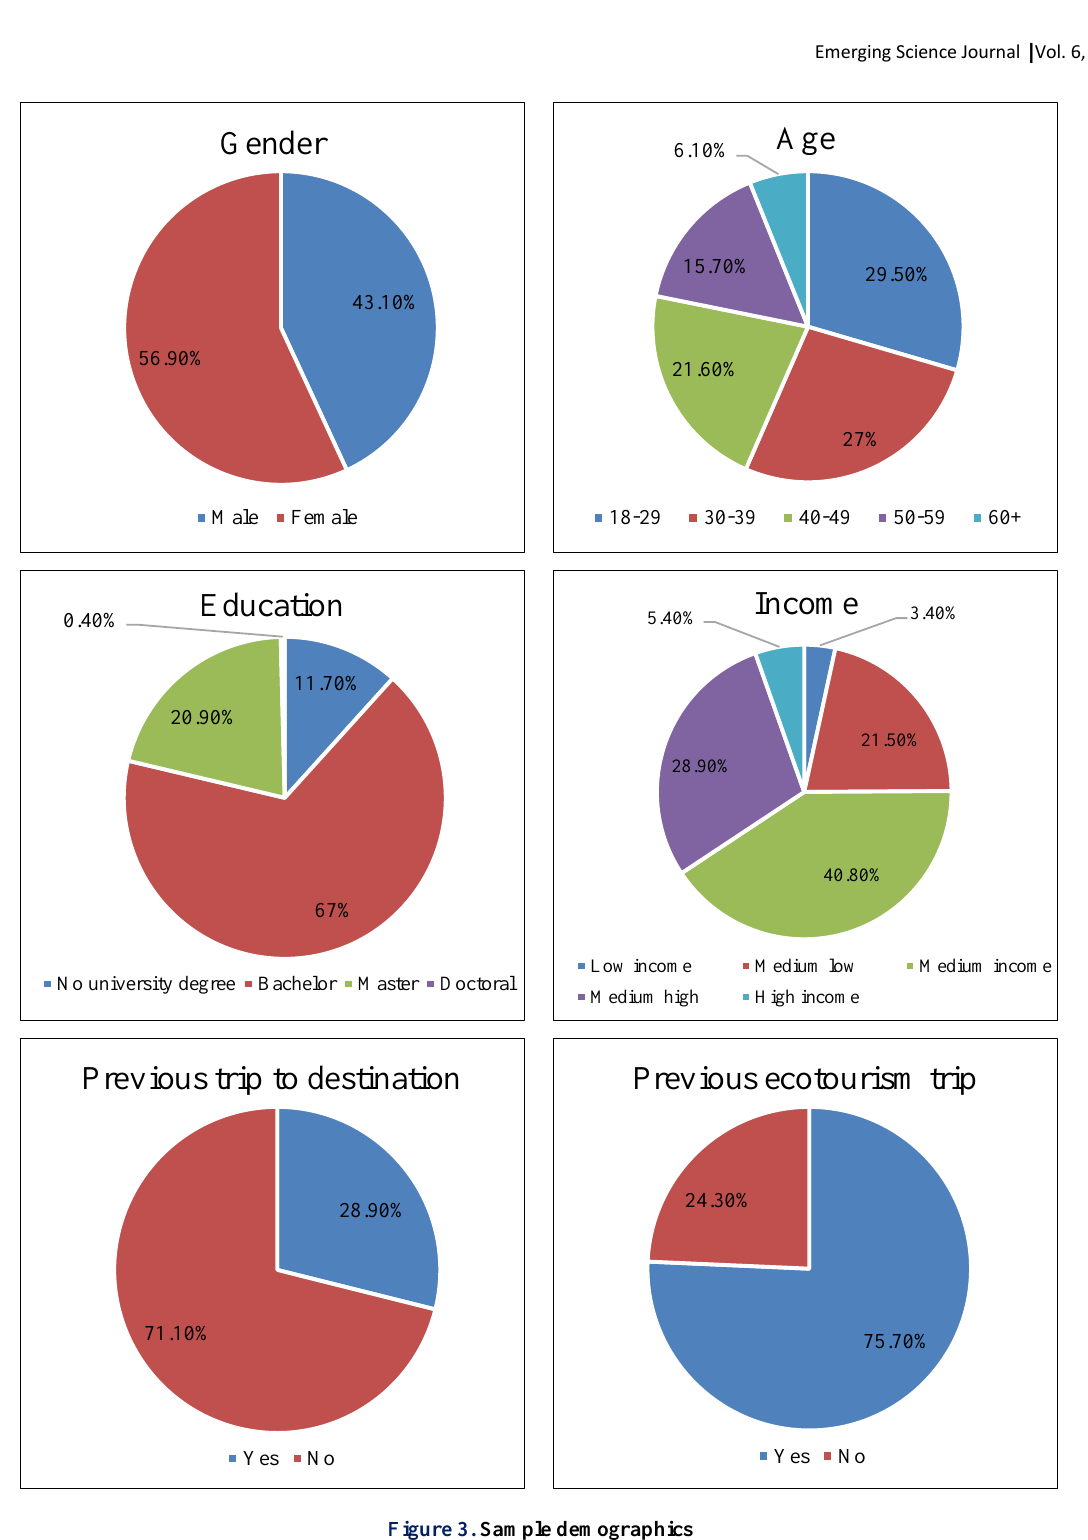
Figure 3. Sample